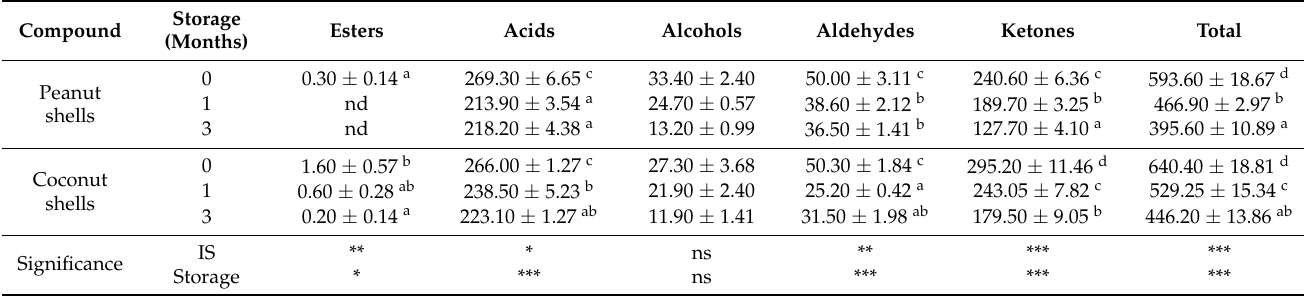
Table 6. Effect of storage on volatile compounds ( µ g kg − 1 ) of fermented milks produced with thermally-dried immobilized L. casei on peanut shells and coconut